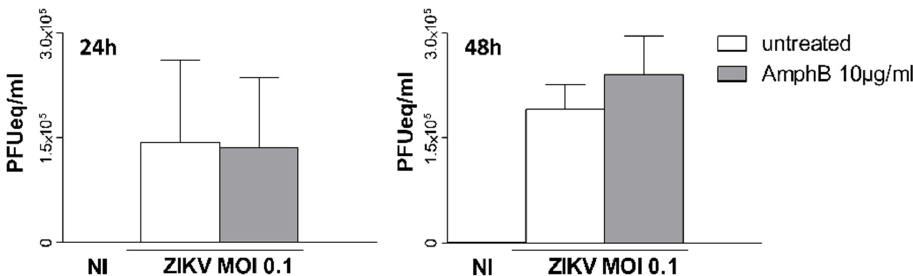
Figure 4. AmphB does not have virucidal activity on ZIKV. AmphB at 10 µg/mL was added to ZIKV stock and incubated at 37 °C for 1 h. Vero cells were then infected at MOI 0.1 with AmphB-treated virus; viral detection was performed on cell supernatants by qRT-PCR after 2 and 4 days of culture and expressed as PFU equivalents/mL (PFUeq/mL). NI: non-infected. Results are expressed as mean ± SD of two independent experiments performed.